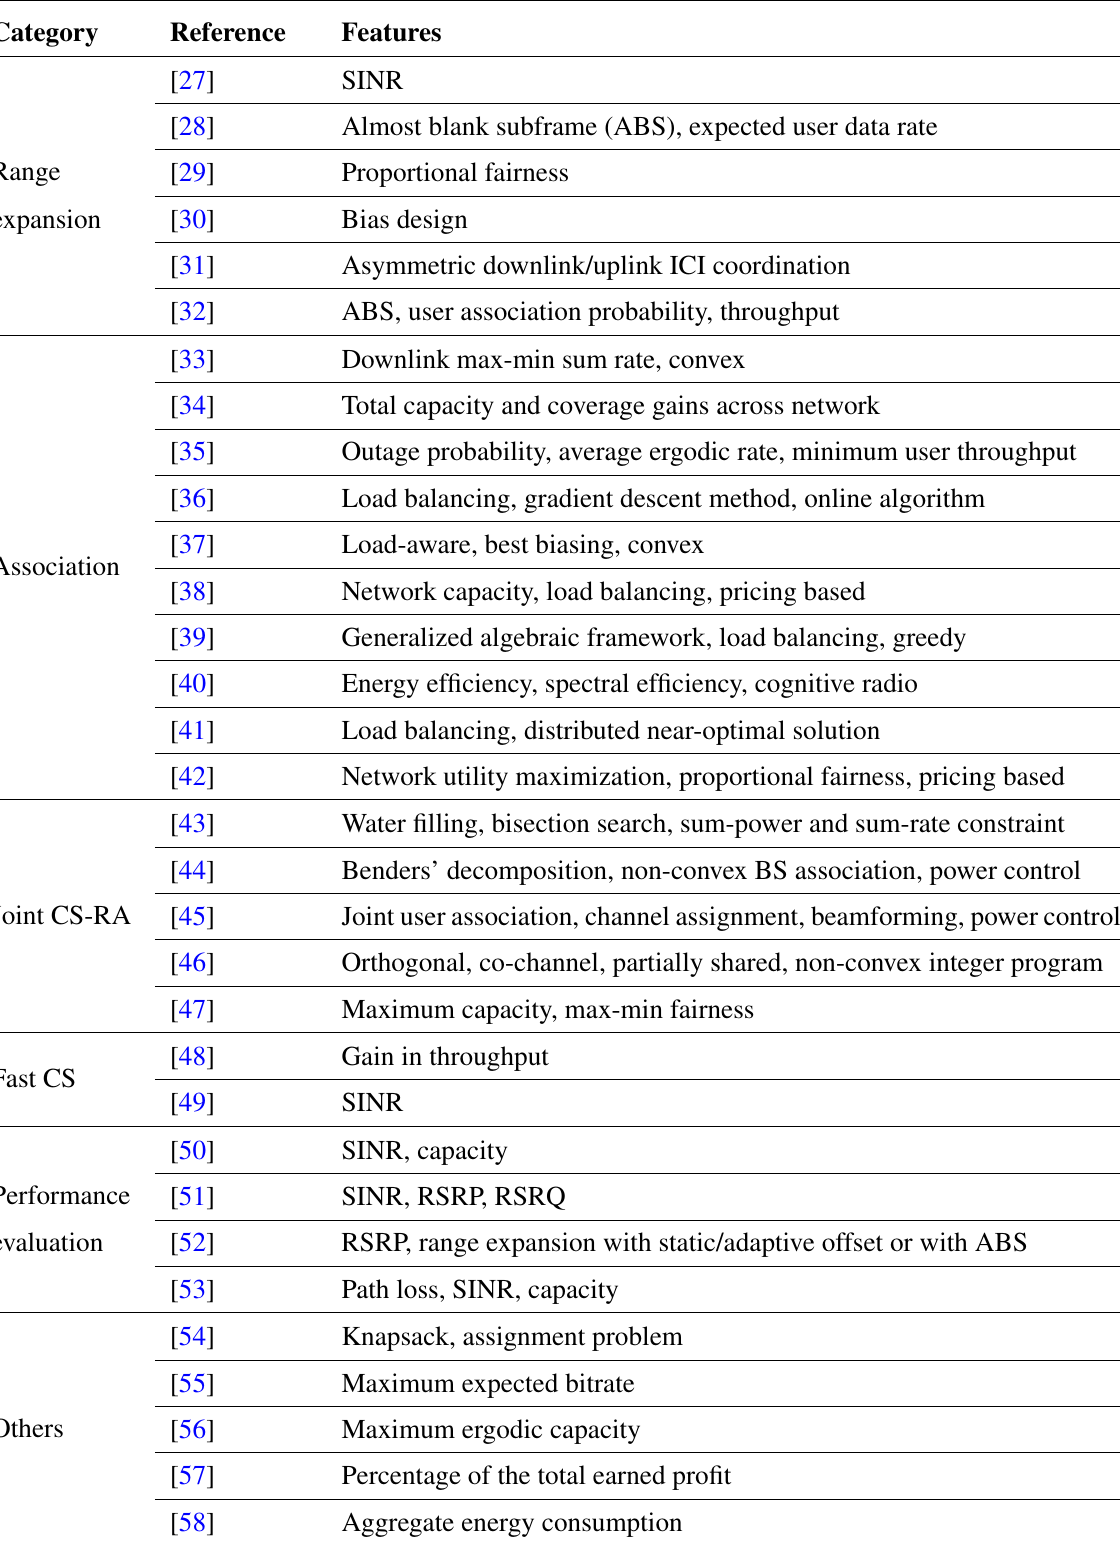
Table 1. Summary of CS optimization of the entire